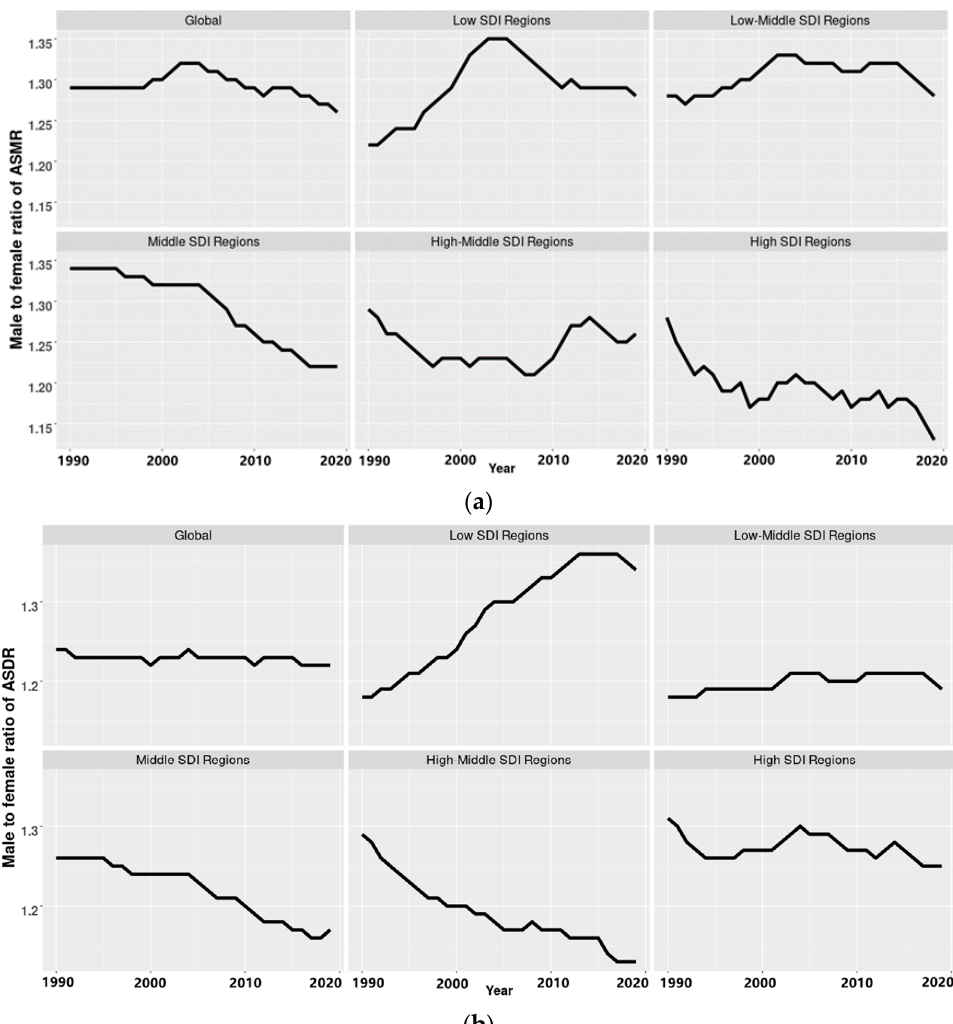
Figure 4. ( a ) The ratio of age-standardized mortality rates (ASMR) in males to that in females in the world and regions with different levels of socio-demographic index (SDI) from 1990 to 2019. ( b ) The ratio of age-standardized disability-adjusted life years rate (ASDR) in males to that in females in the world and regions with different levels of socio-demographic index (SDI) from 1990 to 2019.